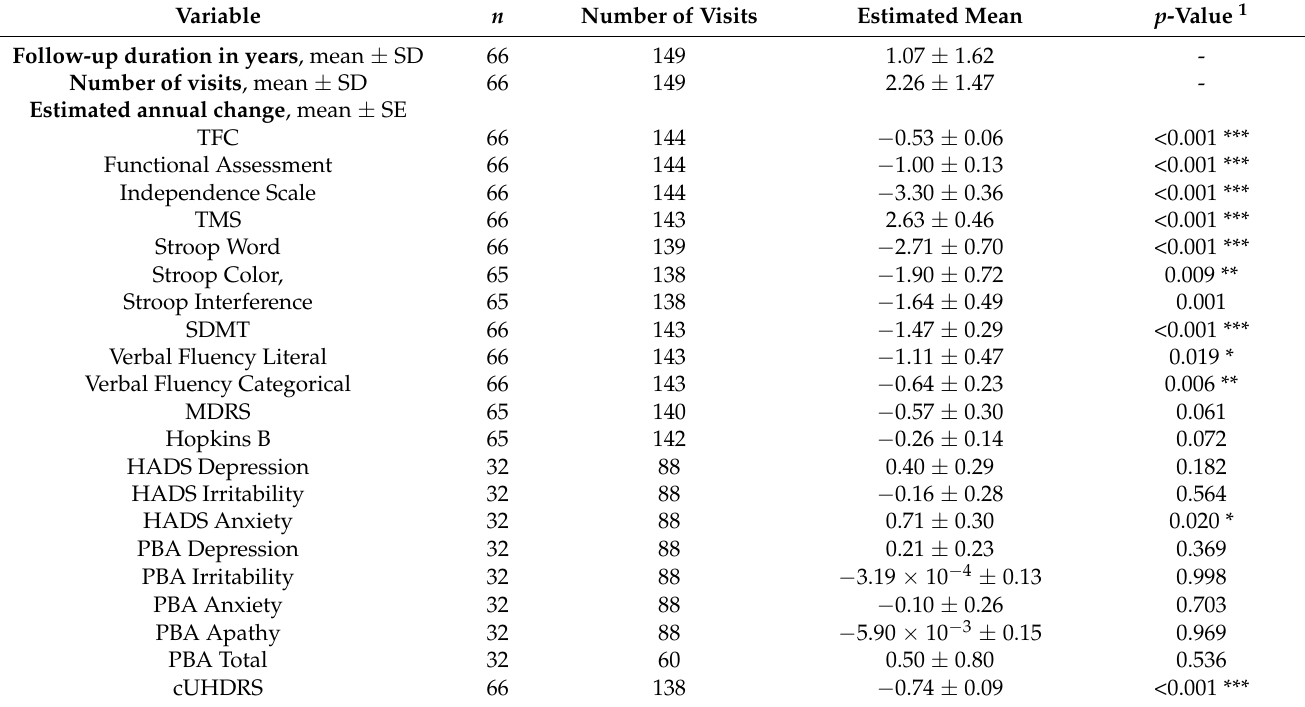
Table 2. Longitudinal decline in HD